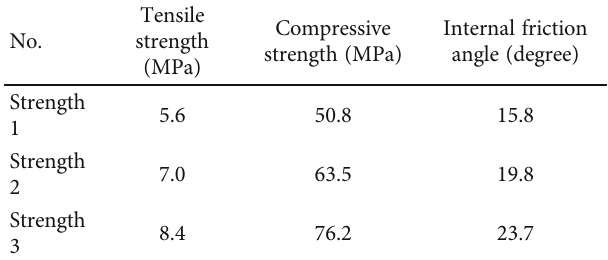
Figure 14: Breakdown pressure with di ff erent dip angles of bedding